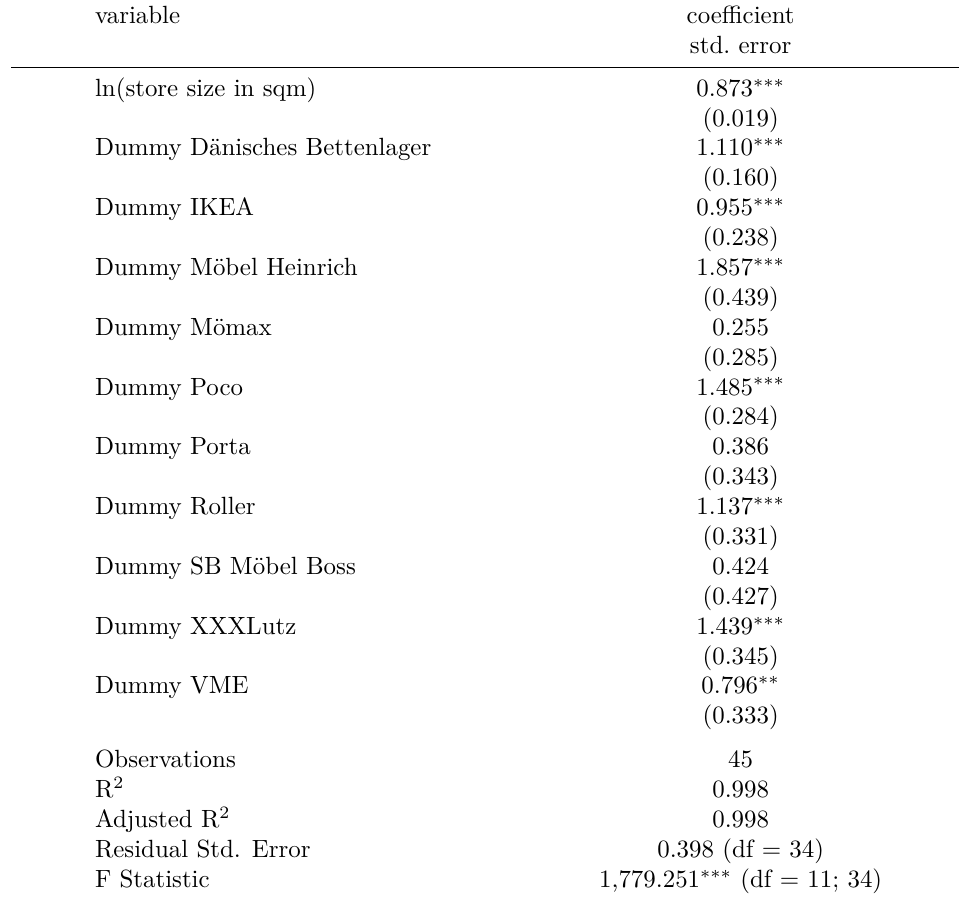
Table 3: Estimation results for the assortment model for furniture stores – Dependent variable: ln(number of